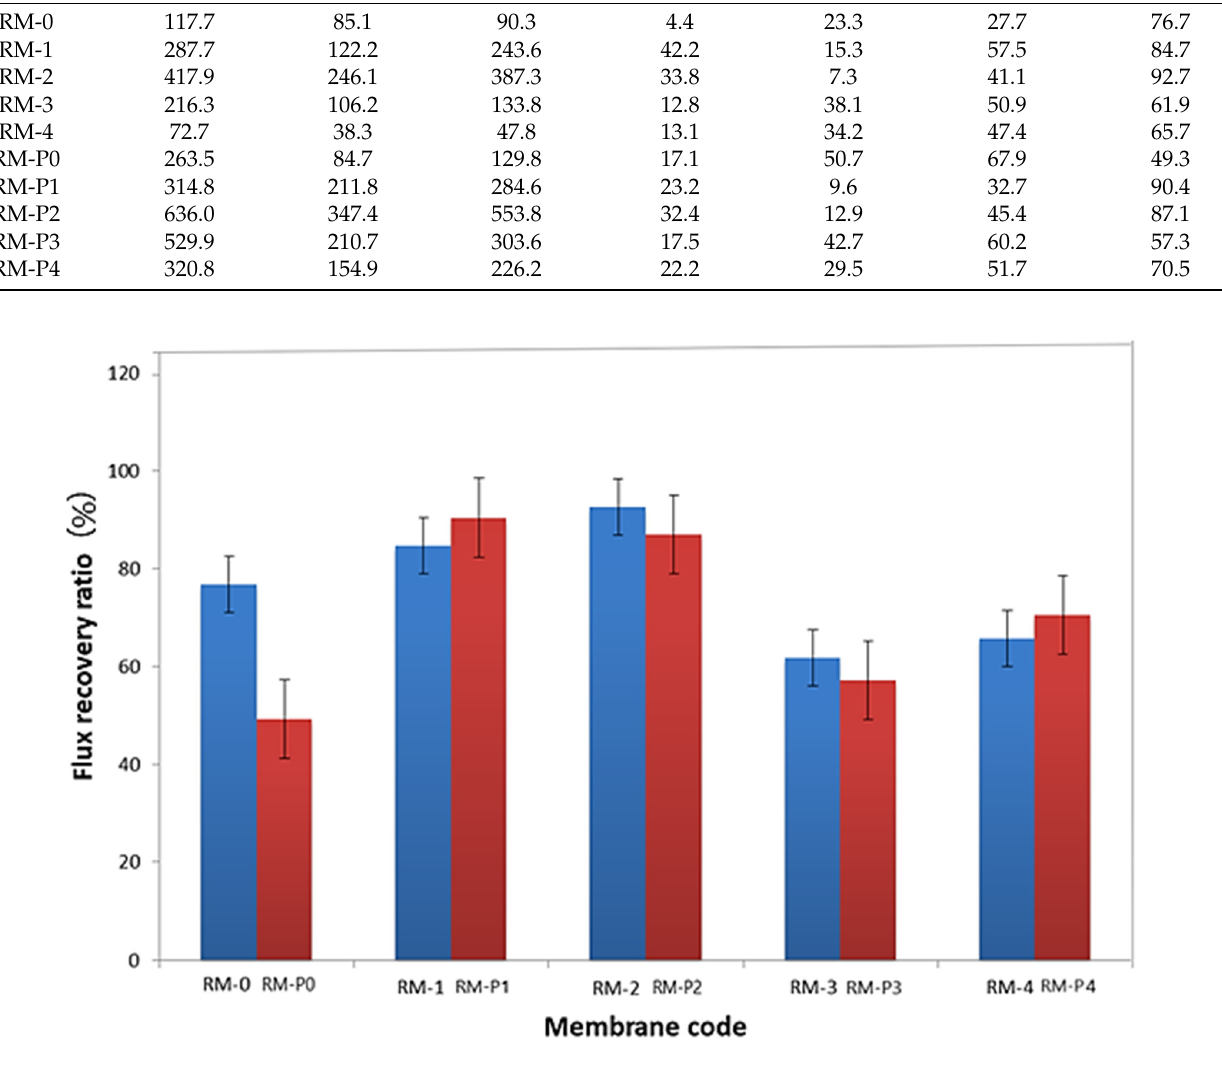
Figure 12. Water flux recovery ratio (FRR %). Table 4. Antifouling properties of prepared membranes.